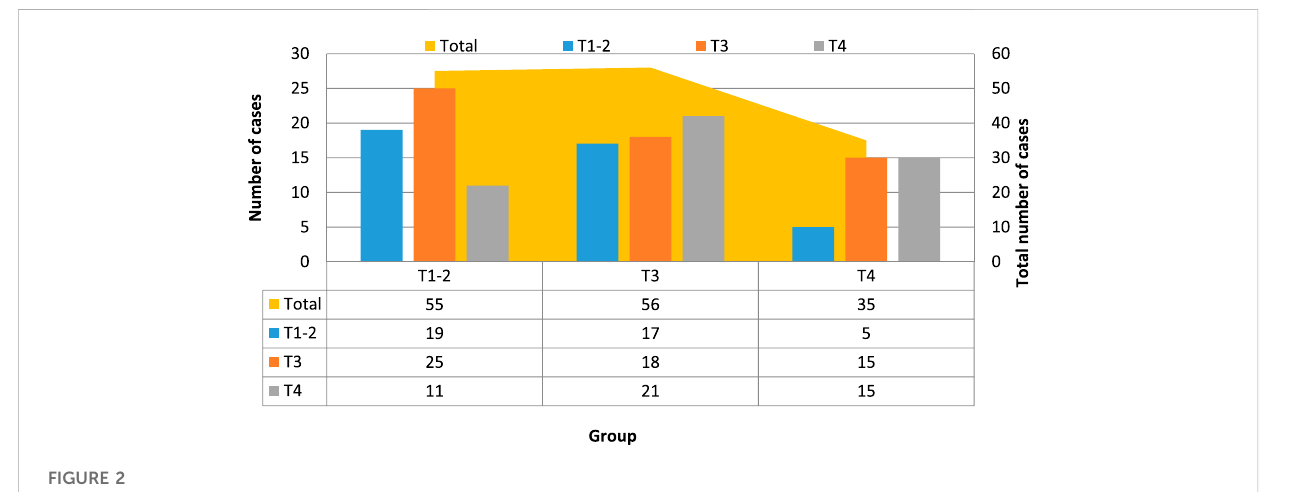
FIGURE 2 Comparison of MR staging and pathological T